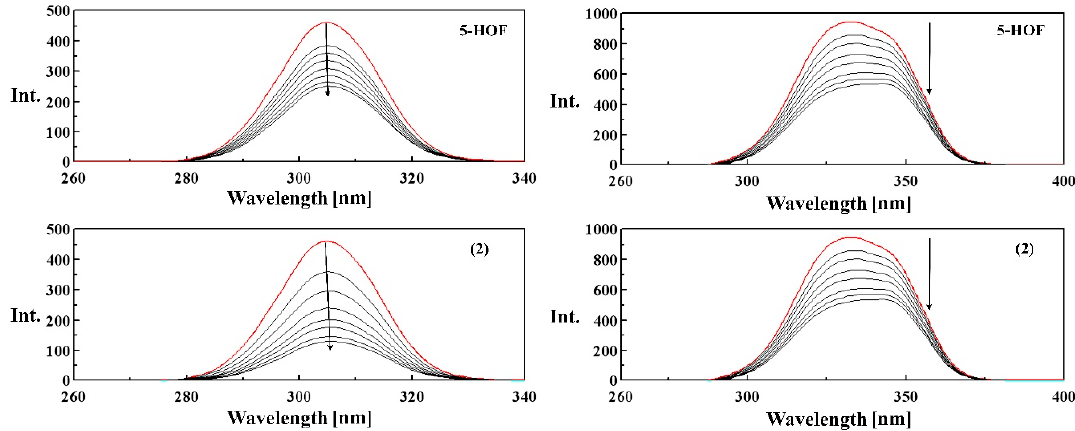
Figure 9. Fluorescence synchronous spectra of 5-HOF and complex ( 2 ) at Δλ = 15 nm ( left ) and 60 nm ( right ). [Tf] = 10 µM, pH = 7.4; [tested compound] = 0; 5; 7.5; 10; 12.5; 15; 17.5; 20 µM. Arrows indicate the changes in fluorescence intensities upon increasing the amounts of the tested compound.